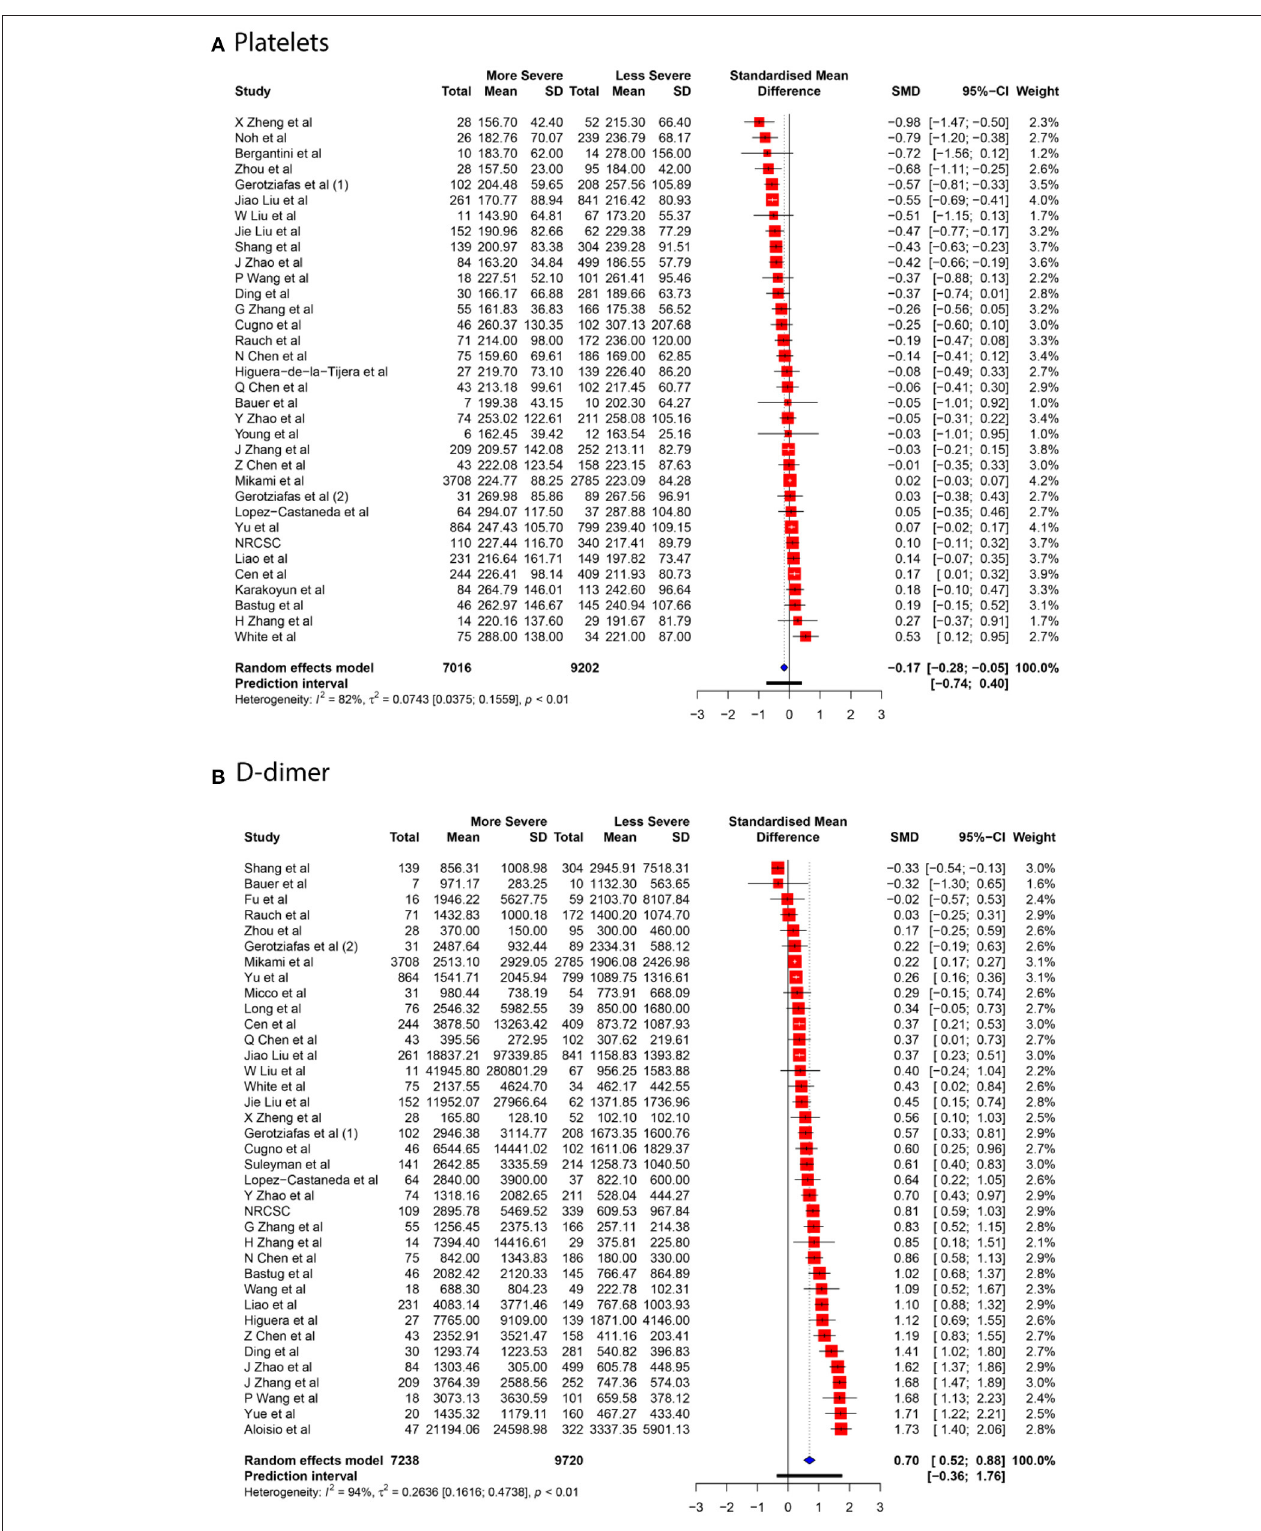
FIGURE 3 | Forest plot of association between COVID-19 severity and PLT (A) , DD (B) .